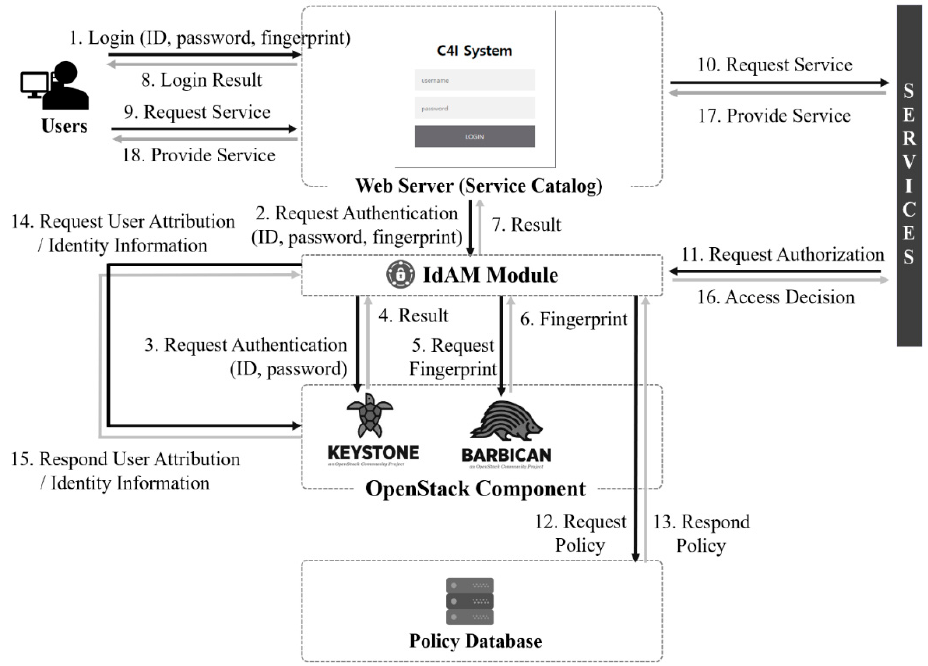
Figure 8. Authentication and Access Control in the OpenStack C4I system.